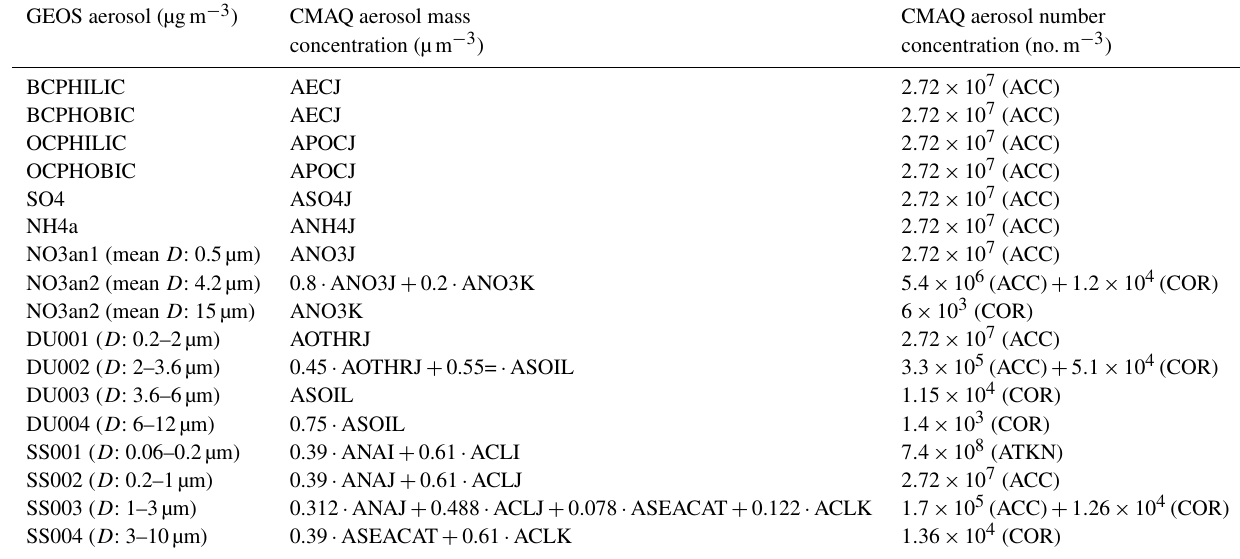
Table 3. Aerosol species mapping table from GEOS to CMAQ AERO6 (“ D ” represents the diameter of the GEOS aerosol bin). GEOS aerosol (µgm − 3 ) CMAQ aerosol mass CMAQ aerosol number concentration (µm − 3 ) concentration (no.m − 3 ) 2 . 72 × 10 7